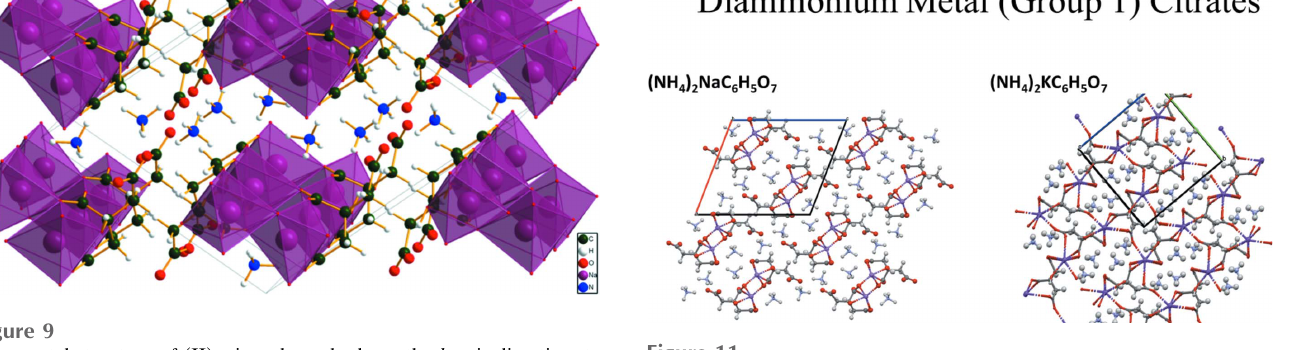
Figure 11 Comparison of the crystal structures of (II) and (NH 4 ) 2 KC 6 H 5 O 7